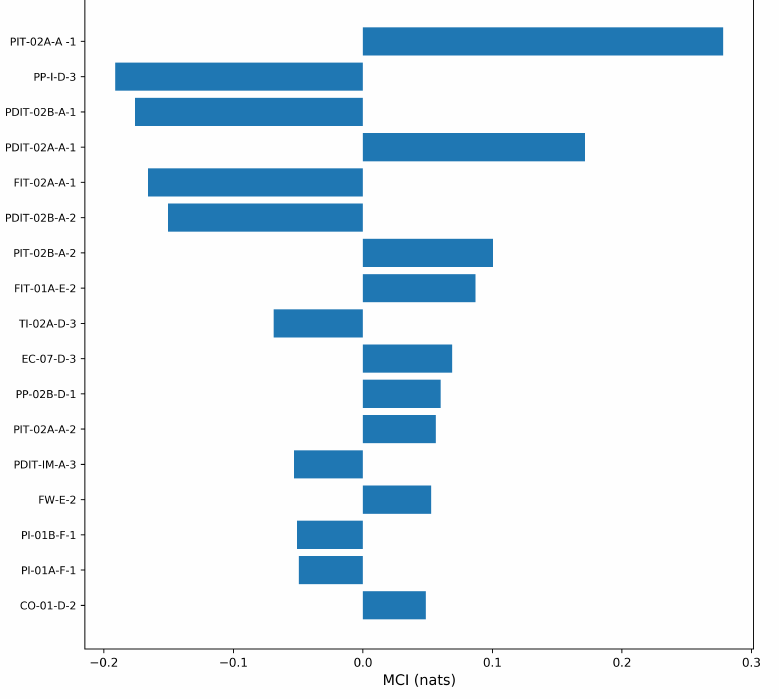
Figure A12. Variables subset for Fault F-I detection selected by the PCMCI (partial correlation)